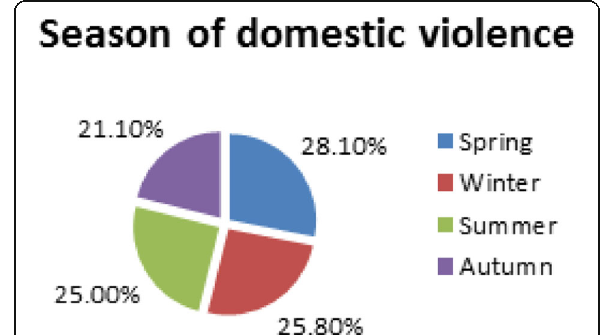
Fig. 2 Distribution of studied cases according to seasons of the year